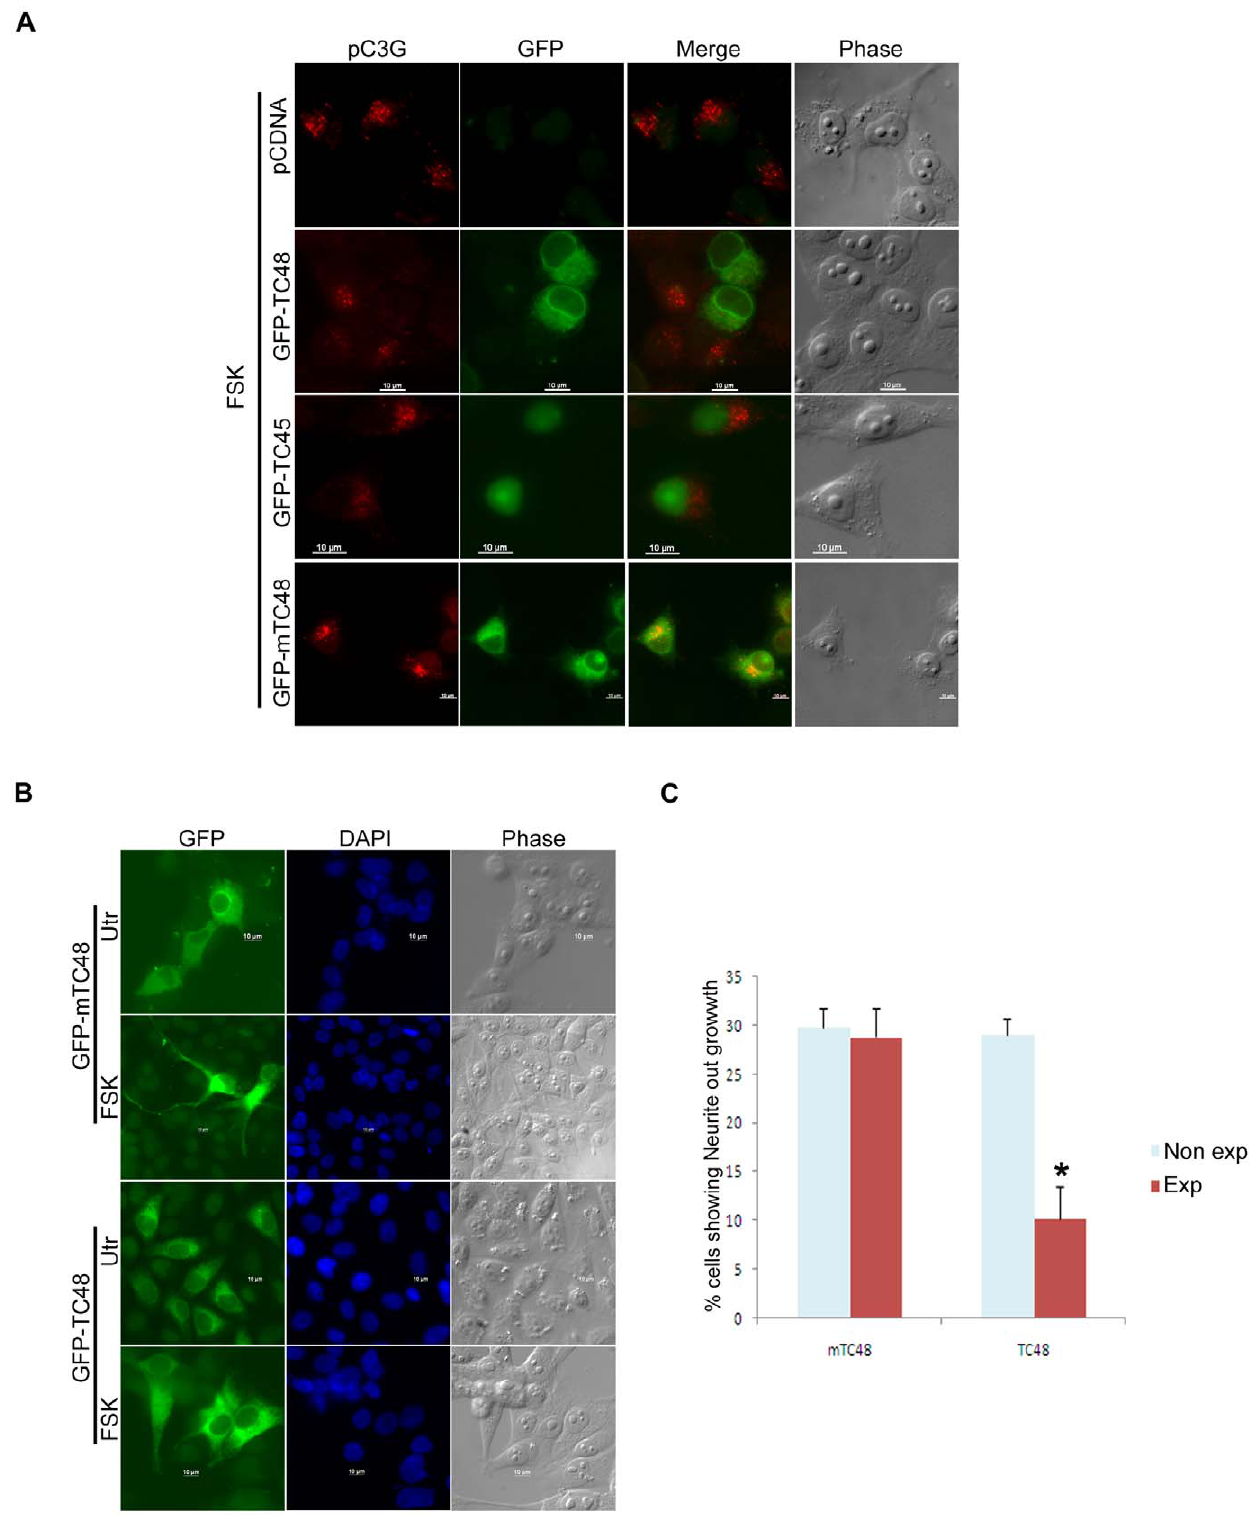
Figure 8. TC48 expression inhibits forskolin induced phosphorylation of C3G at the Golgi and neurite growth. (A) IMR-32 cells transfected with pCDNA, GFP-TC45, GFP-TC48 or GFP-mTC48 were treated with forskolin for 2 hrs, fixed and stained for pC3G. Bar, 10 m m. (B) IMR-32 cells transfected with GFP-TC48 or GFP-mTC48 were left to grow in normal medium (Utr) or induced to differentiate by treatment with forskolin for 72 hrs (FSK). Cells were fixed and observed for neurite growth in GFP positive cells using a fluorescence microscope. (C) Quantitation of neurite growth in GFP positive and negative cells after transfection with GFP-TC48 and GFP-mTC48 upon forskolin treatment. *p , 0.01.